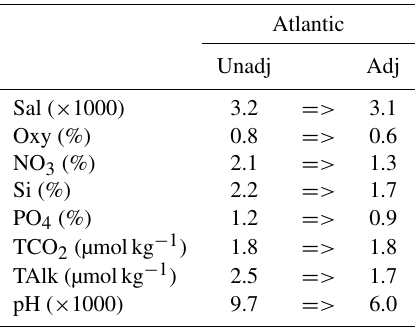
Figure 6. Distribution of applied adjustments per decade for the 840 cruises included in GLODAPv2.2019. Dark blue: not adjusted; light blue: absolute adjustment is smaller than initial minimum ad- justment limit (Table 3); orange: absolute adjustment is between limit and 2 times the limit, red: absolute adjustment is larger than 2 times the limit. Table 8. Improvements resulting from the quality control of At- lantic cruises south of 50 ◦